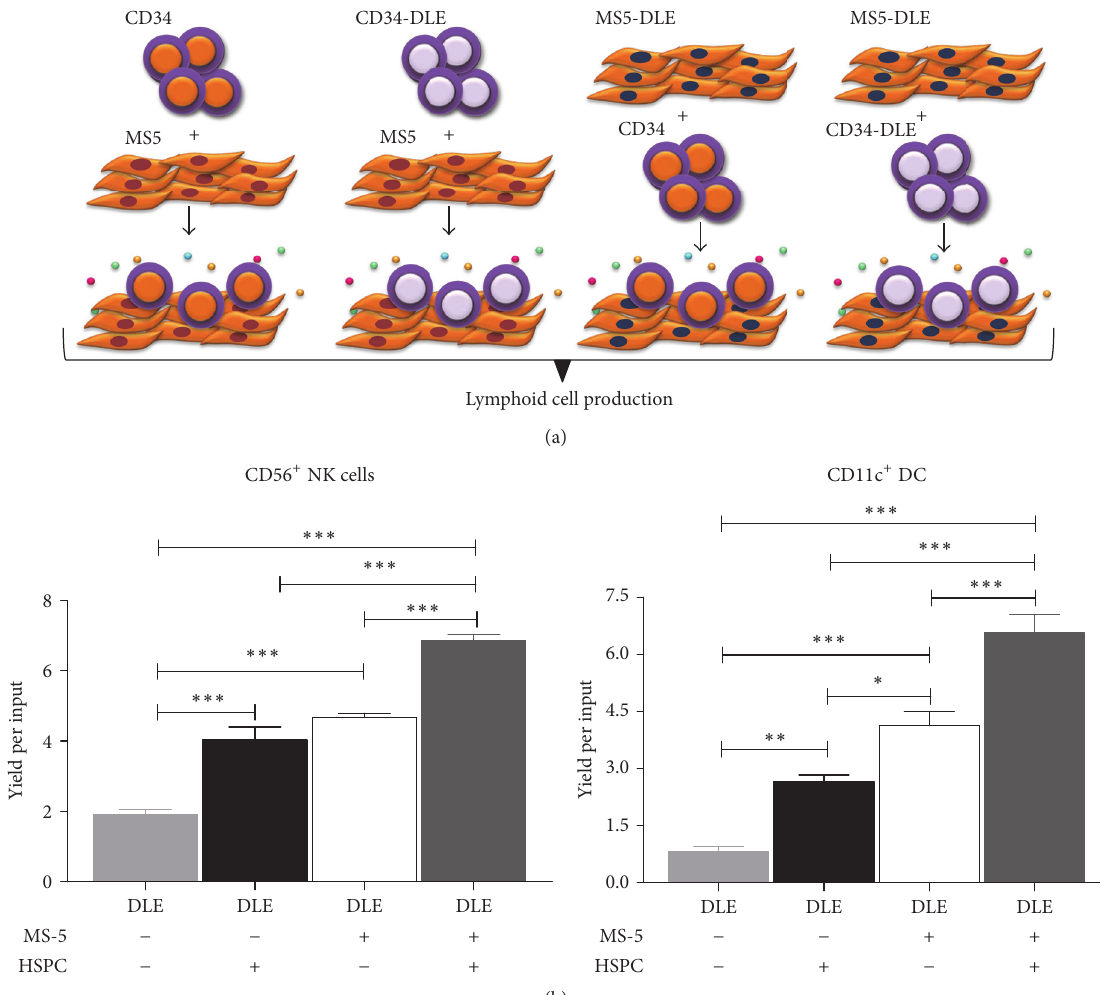
Figure 3: Stromal cell activation by DLE increases the emergent innate immune cell differentiation. MS-5 stromal cells were exposed or not to DLE Transferon 24 hours before coculturing with CD34 + hematopoietic stem and progenitor cells (HSPC) that were pretreated 24 hours with DLE Transferon (a). All conditions were placed in lymphoid lineage cocultures for 30 days followed by flow cytometry analyses of CD56 + NK cells and CD11c + DC production. Yields per input progenitor were tabulated to show the positive contribution of activated stromal cells to innate differentiation (b). DLE, dialyzable leukocyte extracts Transferon. ∗ 𝑃 < 0.05 ; ∗∗ 𝑃 < 0.01 ; ∗∗∗ 𝑃 < 0.001